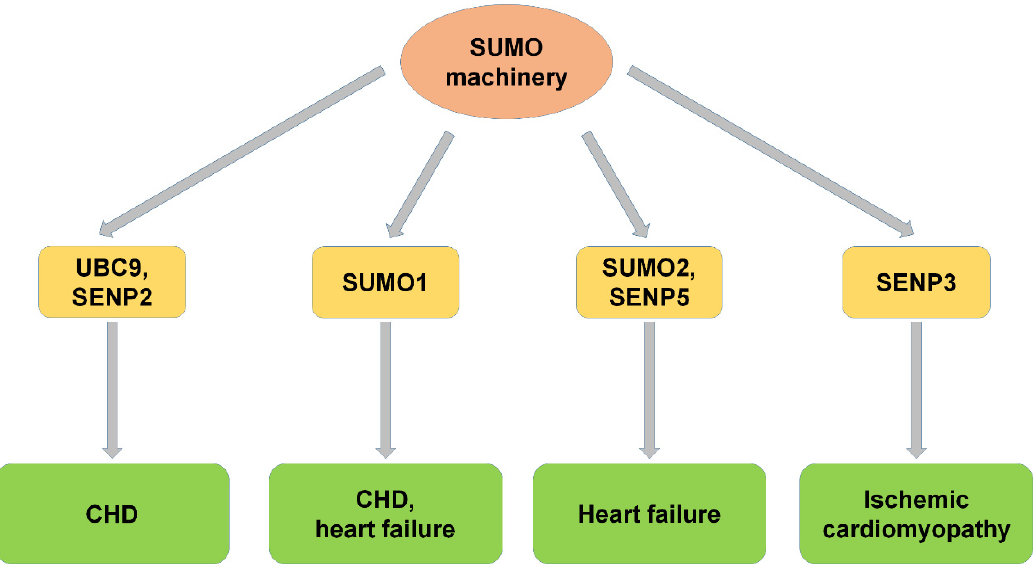
Figure 2. SUMO machinery and CVD. SUMO machinery, including UBC9, SUMO1, SUMO2, SENP2, SENP3, and SENP5, participated in the progression of CVDs, including congenital heart disease, heart failure, and ischemic cardiomyopathy. CHD: congenital heart disease. Table 1. SUMO machinery and